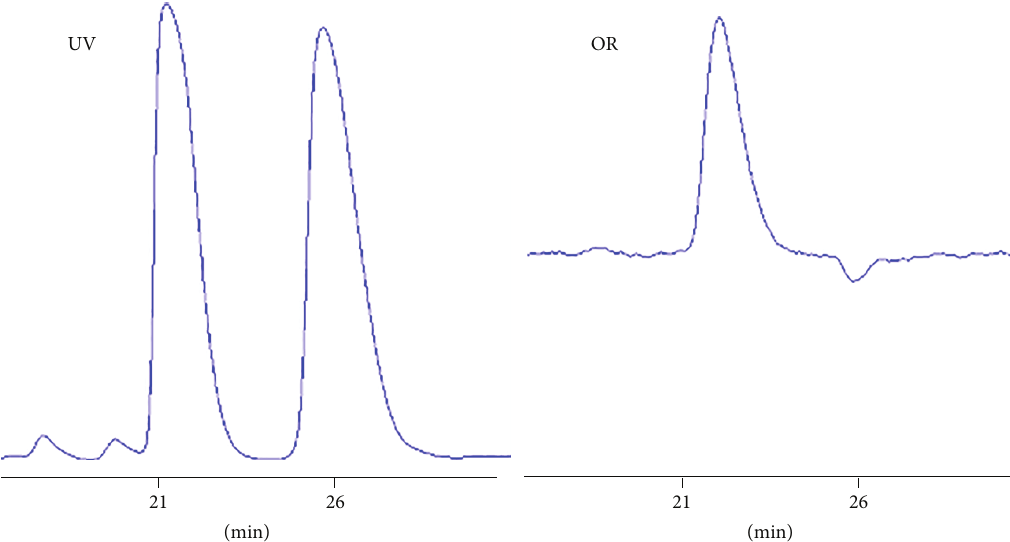
Figure 2: The typical UV and OR chromatograms of TFLV on semipreparative chiral column with 𝑛 -hexane/2-propanol (96/4, v/v) at 2.5 mLmin −1 .